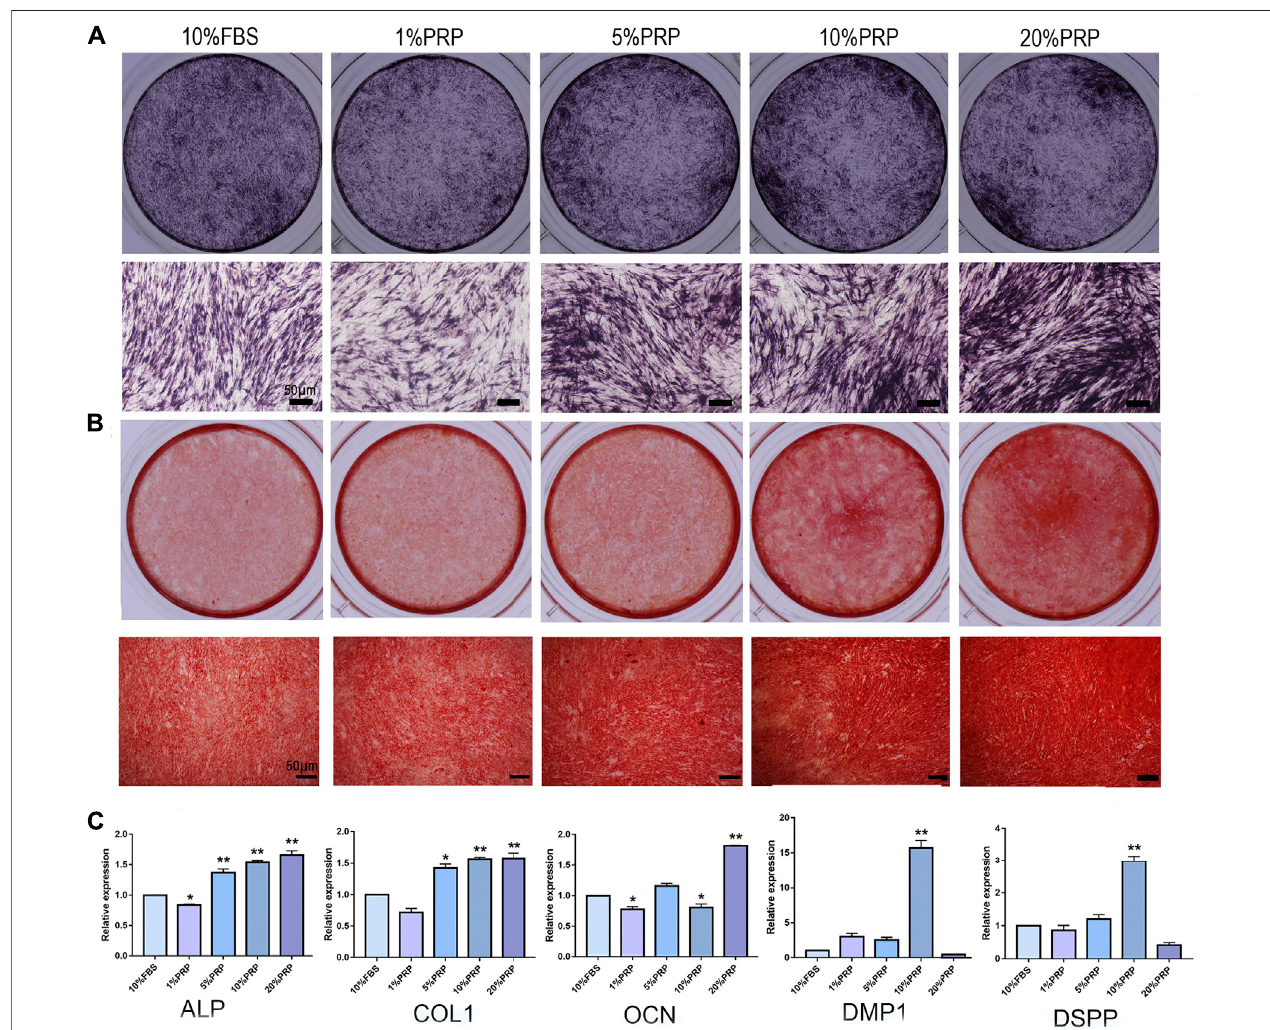
FIGURE 2 | Effectof PRP on cell osteogenic differentiation ofhDPCs was assessed by ALP, alizarin red staining, and real-time quantitative PCR. (A) Cells cultured in the presence ofdifferent concentrationsof PRP were fi xed and stained for ALP (scale bar, 50 μ m). (B) Cells were fi xed and stained with alizarin red (scale bar, 50 μ m). (C) Real-time quantitative-PCR analysis of ALP, COL 1, OCN, DMP-1, DSPP mRNA expression in different groups. Data in (C) are representative of fi ve independent experiments. Data are presented as mean ± standard deviation. Signi fi cantly different groups, * p < 0.05, ** p <